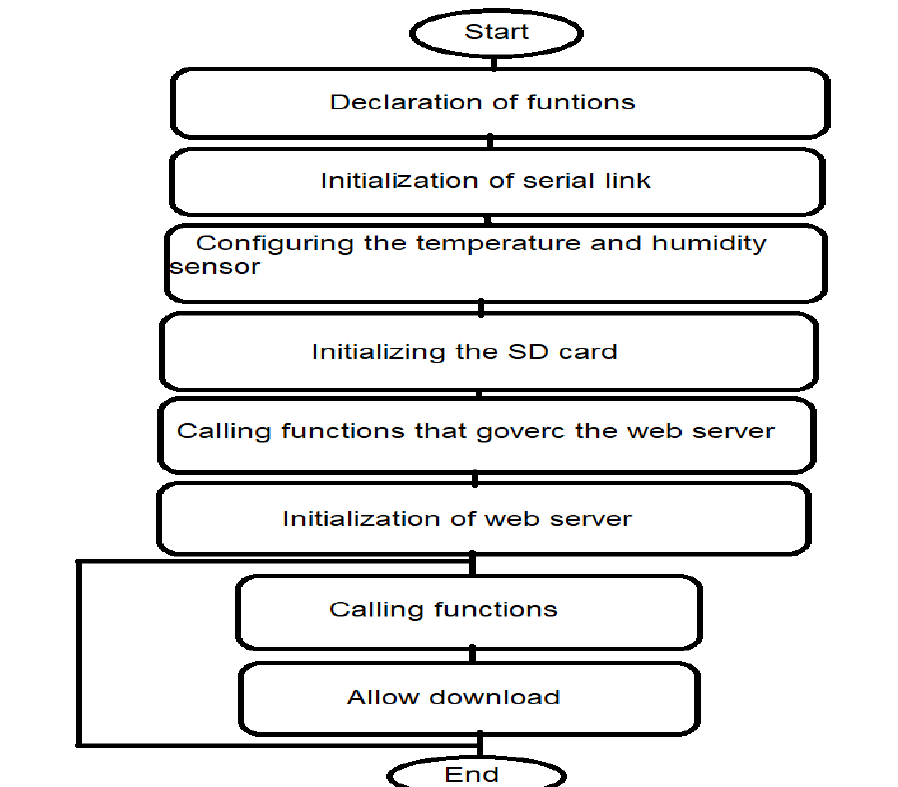
Figure 5 b: Flowcharts of the programs driving the ESP32 Node MCU